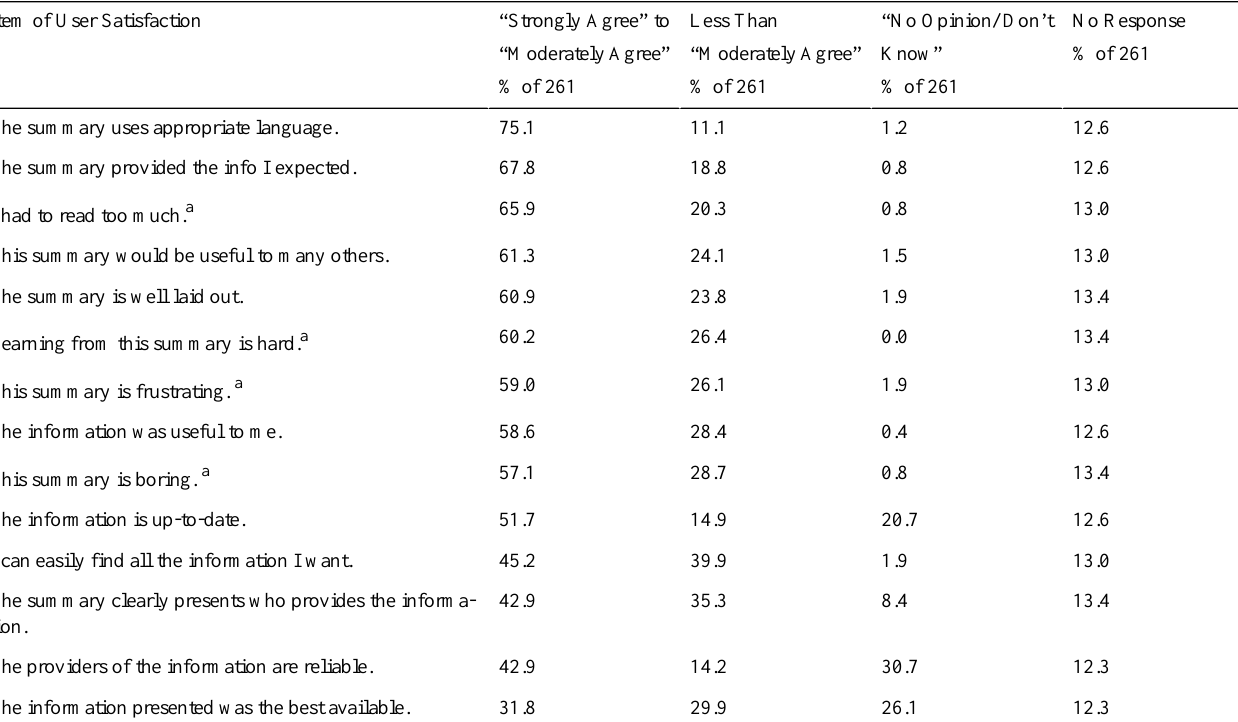
Table 4. Percentage of respondents for items of user satisfaction (higher percentages indicate greater satisfaction)